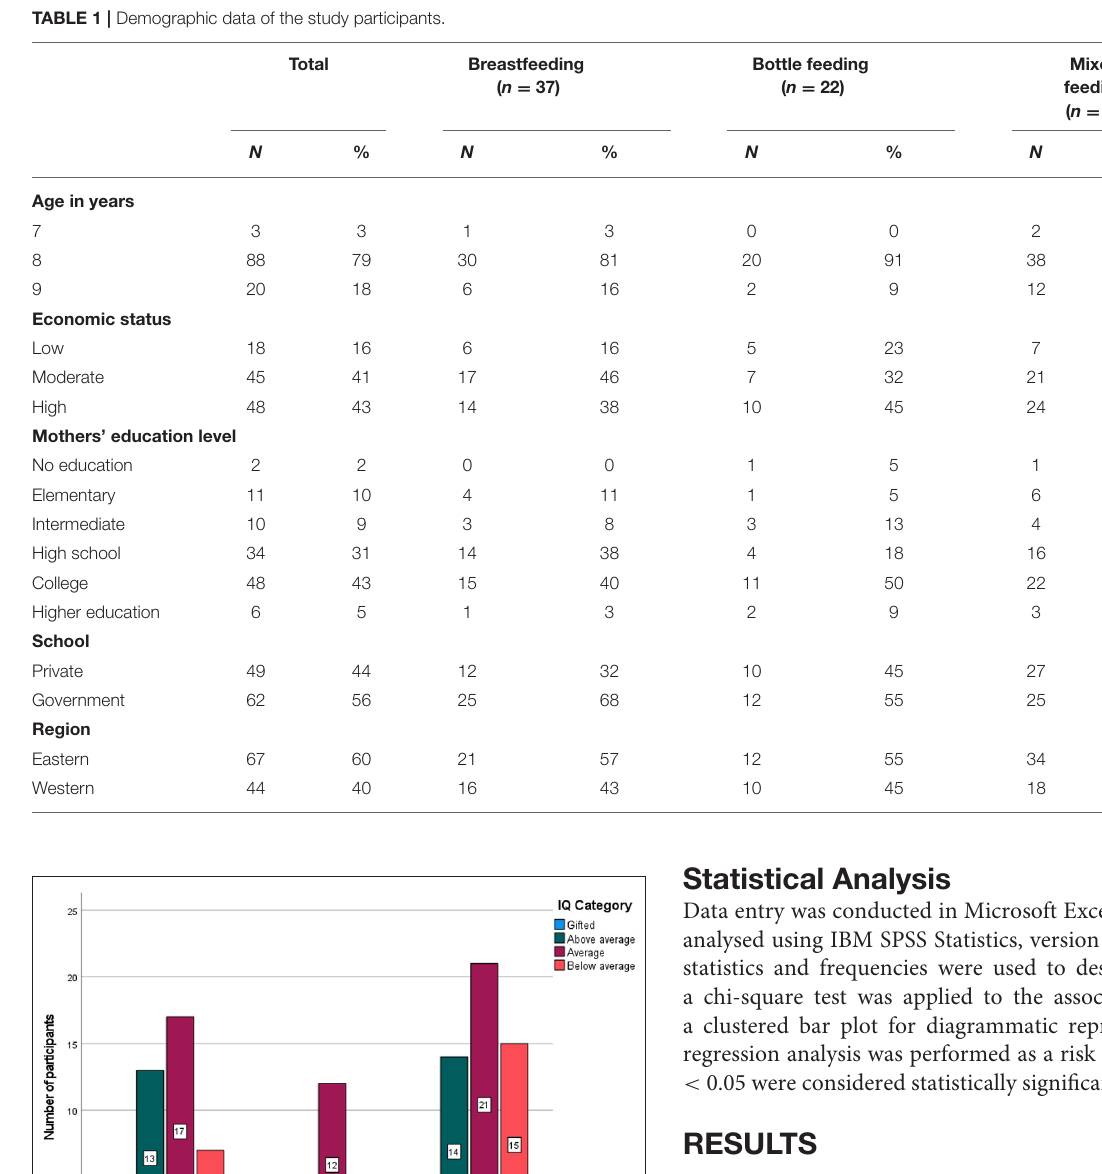
TABLE 1 | Demographic data of the study participants.